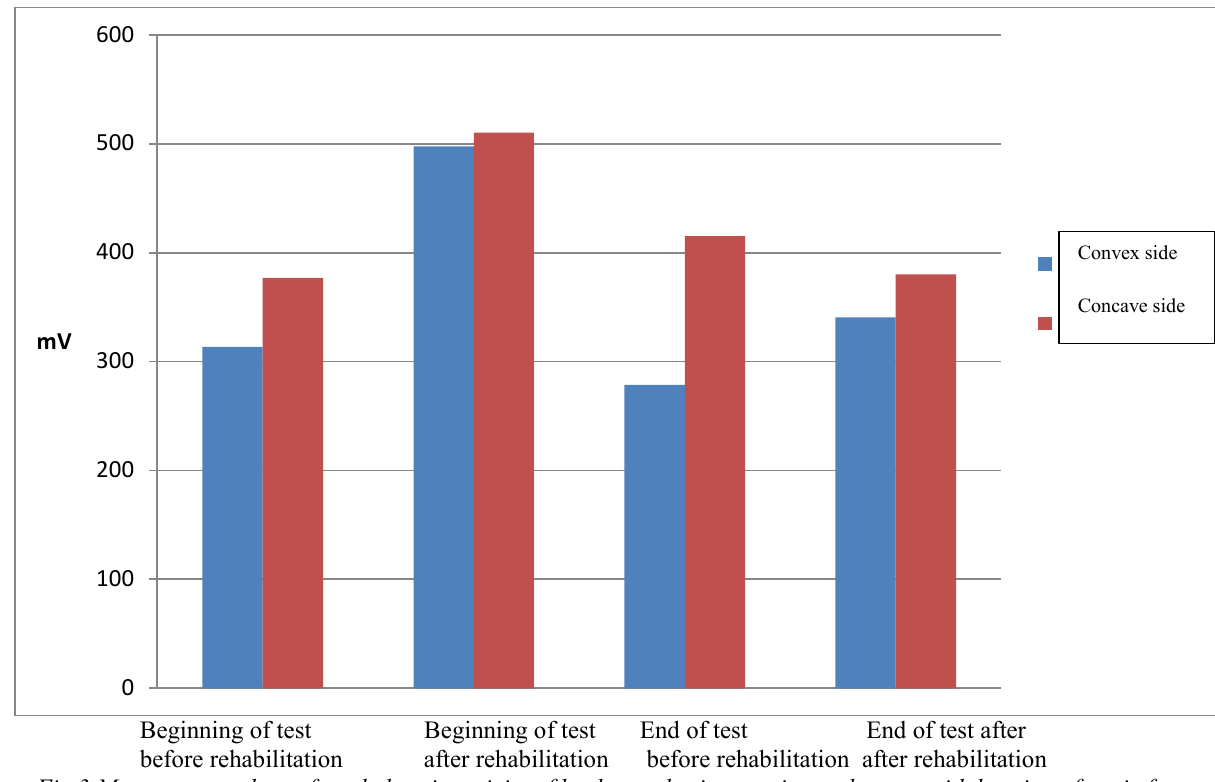
End of test after after rehabilitation before rehabilitation after rehabilitation Fig.3 Mean group values of total electric activity of back muscles in experimental group with keeping of static force before and after